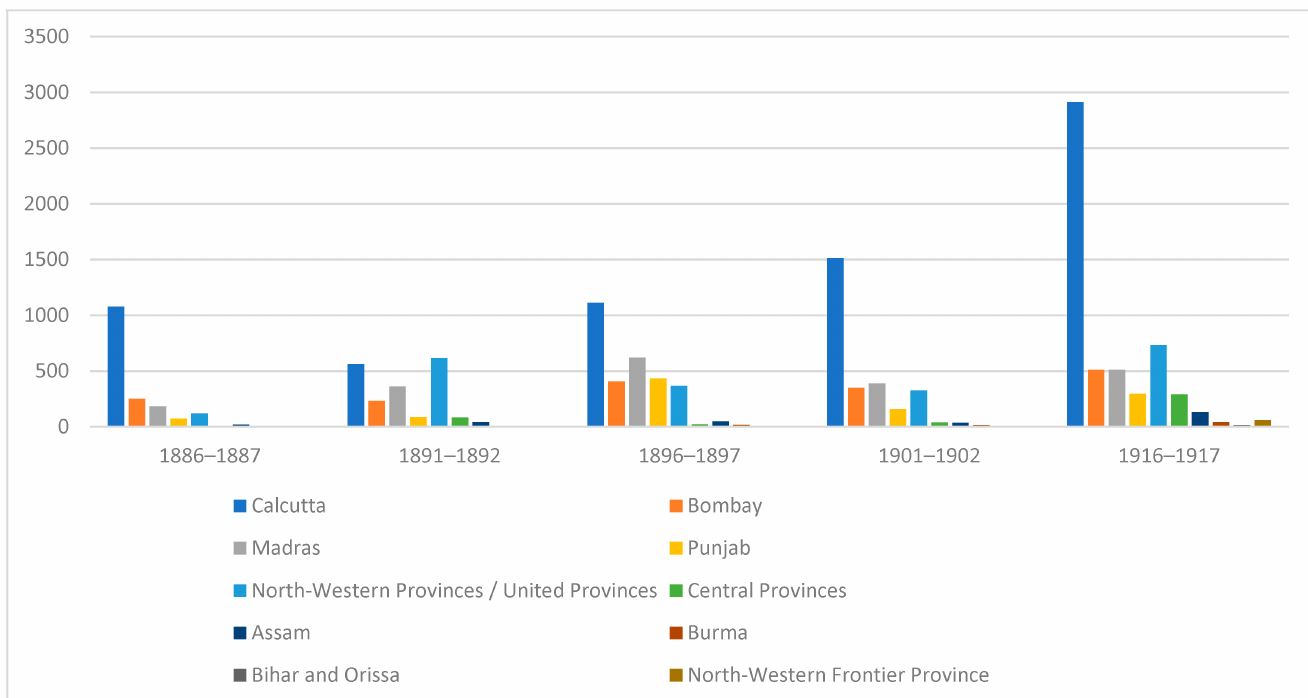
Figure 4. Number of students enrolled in law studies by colonial province, 1886–1917. This figure presents the number of students enrolling in law studies by university from 1886 to 1917. It gives figures for some academic years within this